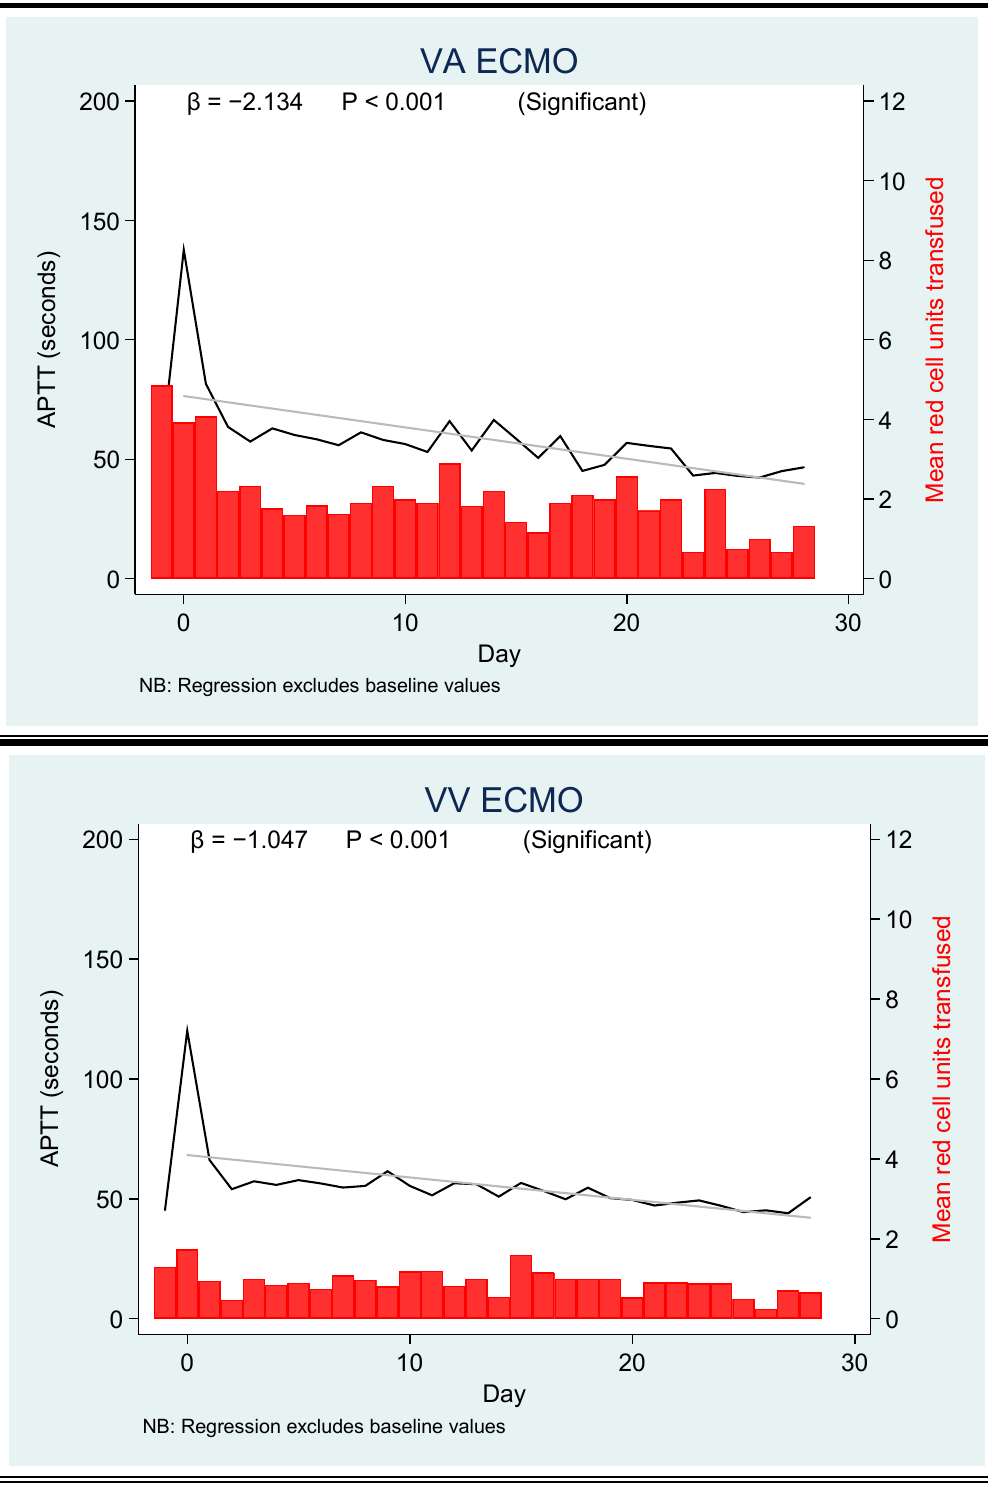
Figure 3. APTT and PRBC transfusion requirements in VA and VV ECMO patients over 28 days. A platelet count < 50 × 10 9 /L or a fibrinogen level < 1.8 g/L was associated with 50% chance of PRBC transfusion, regardless of the ECMO type (Figures 4 and 5 and Supple- mentary Figure S1).